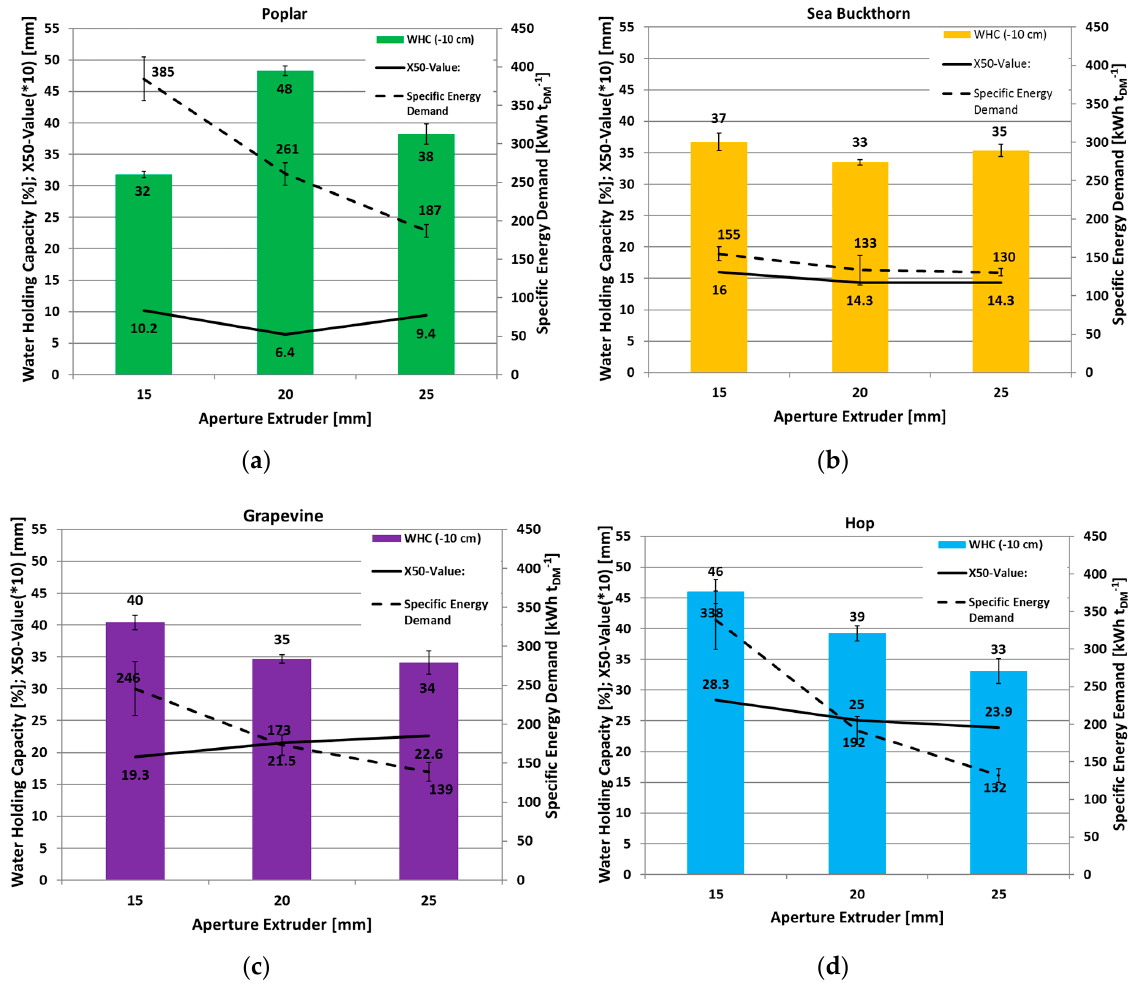
Figure 8. WHC (at − 10 cm water column), X50-value (multiplied by 10) and specific energy demand of ( a ) poplar, ( b ) sea buckthorn, ( c ) grapevine and ( d ) hop as a function of aperture.